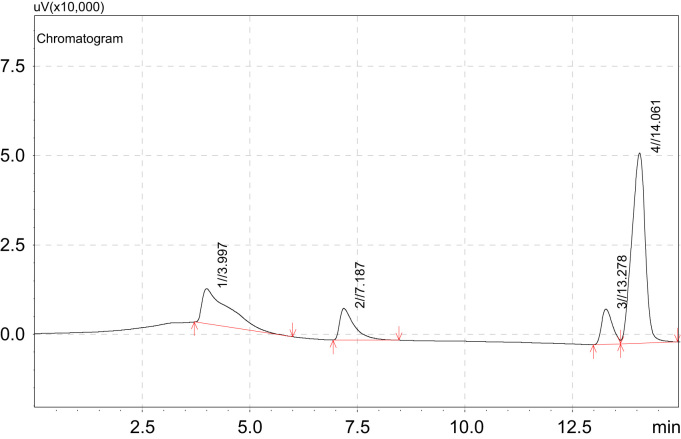
Sample standard.